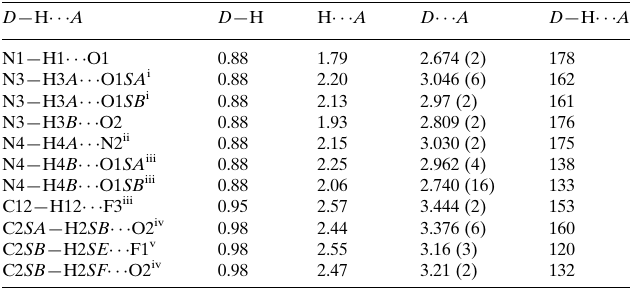
Hydrogen-bond geometry (A˚ , (cid:4)